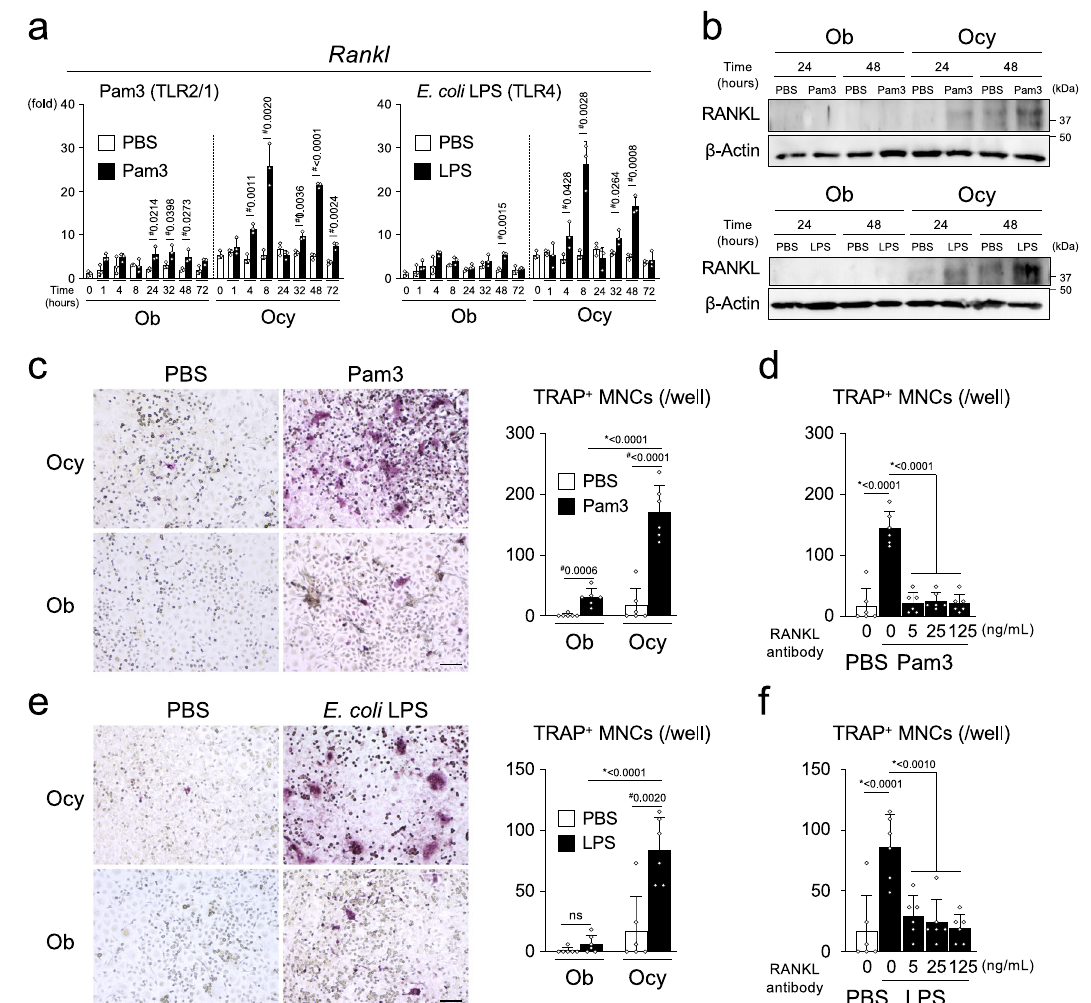
Fig. 4 | PAMPs induce more robust RANKL expression in the osteocyte- enriched cell population thanthe osteoblast-enriched cell population. a qPCR analysis of Rankl in the osteoblast-enriched cell population (Ob) and osteocyte- enriched cell population (Ocy) stimulated with Pam3CSK4 (100ng/mL), E. coli LPS (100ng/mL), or PBS every 24h. Average expression levels in Ob treated with PBS for 0h were set as 1. Representative data from fi ve independent experiments with similarresults, eachwiththree replicates( n =3). b Westernblotting of RANKLwith cell lysates from Ob and Ocy stimulated with Pam3CSK4, E. coli LPS, or PBS. Representative images from fi ve independent experiments with similar results. c – f Co-culture of bone marrow-derived M-CSF-dependent macrophages from Myd88 − / − male mice with Ob or Ocy isolated from wild-type ( Myd88 +/+ ) C57BL/6J